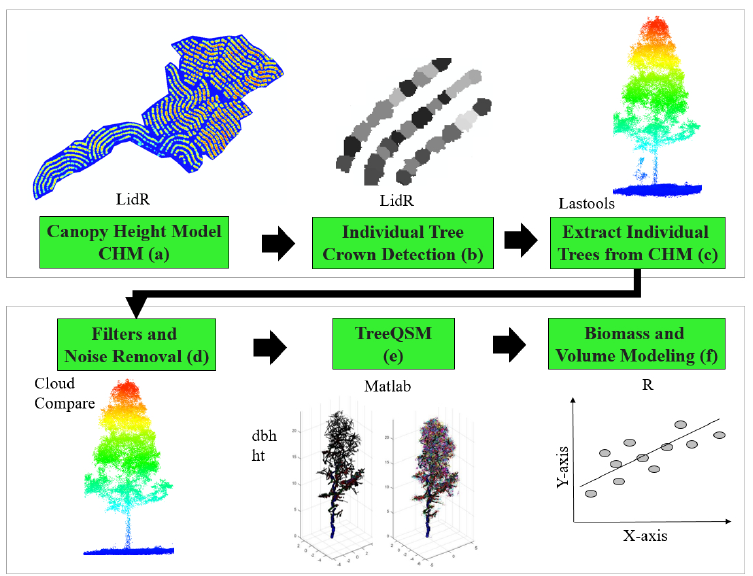
Figure 2. Diagram of UAV-LiDAR point cloud processing: ( a ) pre-processing; ( b ) “.las” normalized and Canopy Height Model—CHM; ( c ) Individual Tree Crown Detection; ( d ) Extract Individual Trees from CHM; ( e ) Filters and Noise Removal; ( f ) Result of